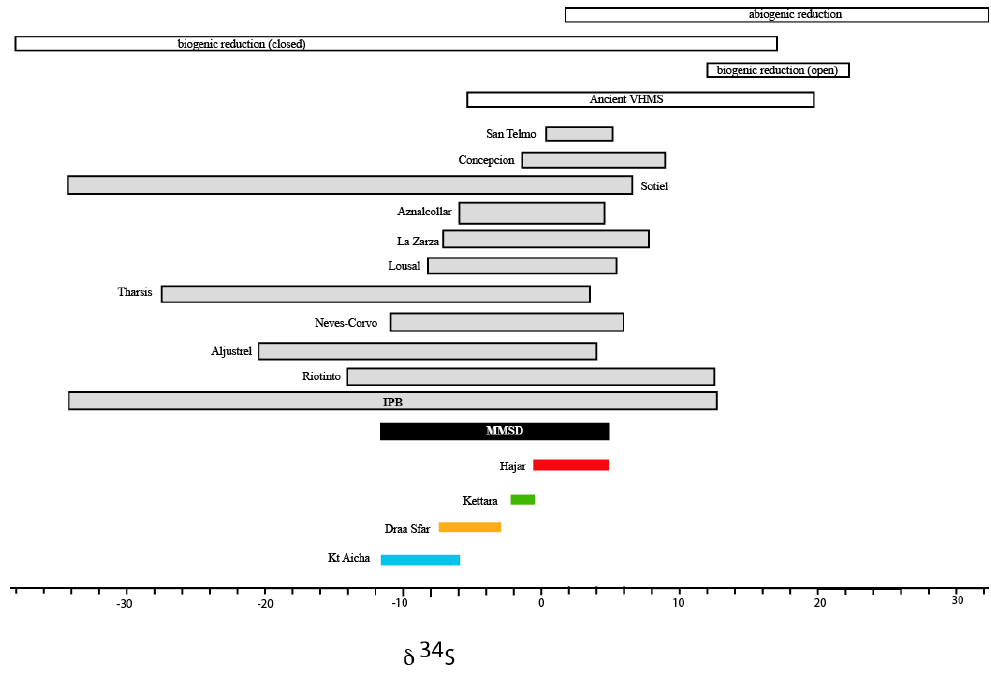
Figure 9. Sulphur isotopes of the main MMSD compared to those of the IPB [121] and the other ancient volcanic-hosted massive sulphides [125–131]. The field of reduced sulphur inherited from the abiogenic reduction of seawater is estimated from [132] and the interval for biogenic reduction sulphate is from [116].